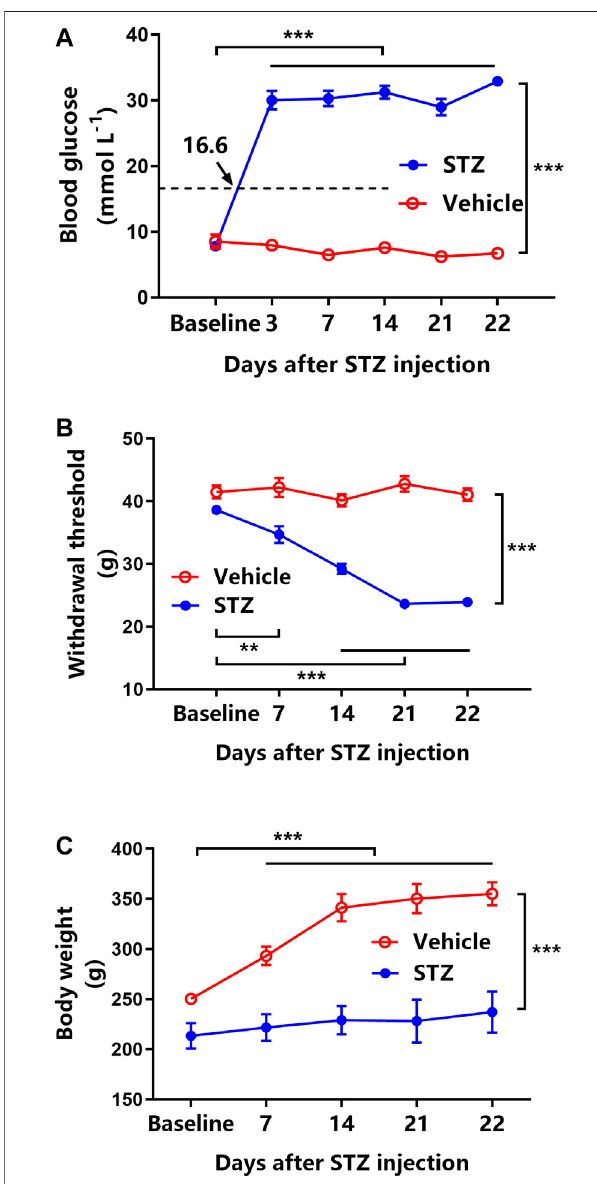
FIGURE 1 | Streptozotocin(STZ)induceshyperglycemia,tactileallodynia, and body weight loss in rats ( n (cid:2) 6 for vehicle-treated rats, n (cid:2) 42 for STZ- induced diabeticrats). (A) Timecourseofblood glucoselevelsinvehicle-treated rats (open circles) and STZ-induced rats ( fi lled circles). ***represents p < 0.001betweenthebaselineandexperimentalvalues. (B) Mechanicalwithdrawal threshold (MWT) of vehicle-treated rats(open circles) and STZ-induced diabetic rats ( fi lled circles). **represents p < 0.01 and ***represents p < 0.001 between thebaselineandexperimentalvalues. (C) Thechangesinbodyweightinvehicle- treated rats (open circles) and STZ-induced diabetic rats ( fi lled circles). ***represents p < 0.001 between the baseline and experimental values. FIGURE 2 | Effect of koumine (KM) on mechanical allodynia in rats with